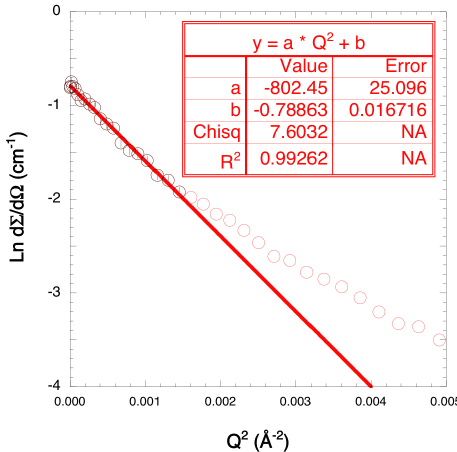
Figure 6. Guinier approximation of the simulated SCS by using the SDF with σ = 0.4 and an incoherent background of 1.0 × 10 − 4 cm − 1 . The points used for the Guinier approximation are shown with black symbols, while the others are red. The fit is shown with a red line.